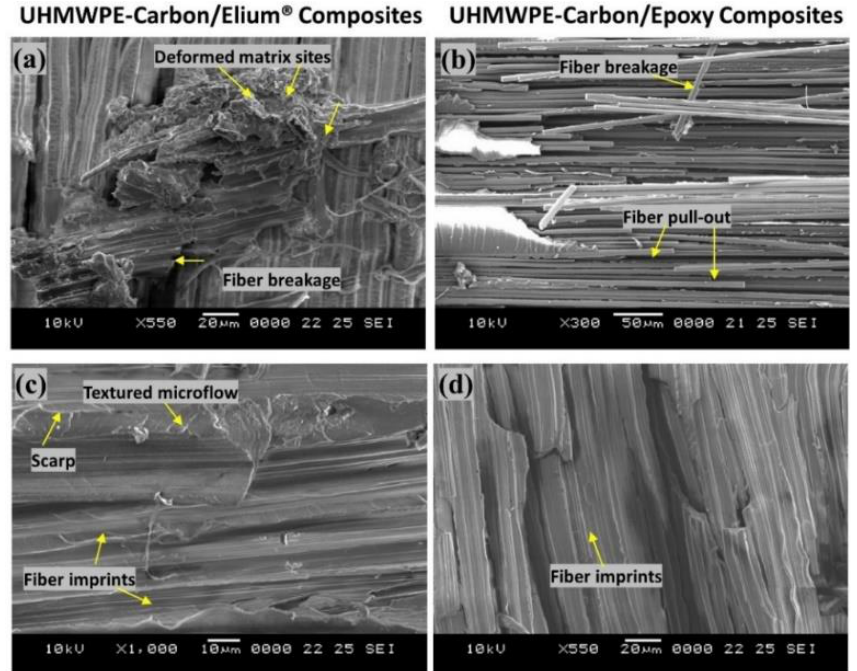
Figure 14 . Surface morphological images of fractured surfaces of composites using Scanning Elec- tron Microscopic approach of ( a , c ) Carbon_UHMWPE/Elium ® ( b , d ) Carbon_UHMWPE/Epoxy composite under Mode I loading .